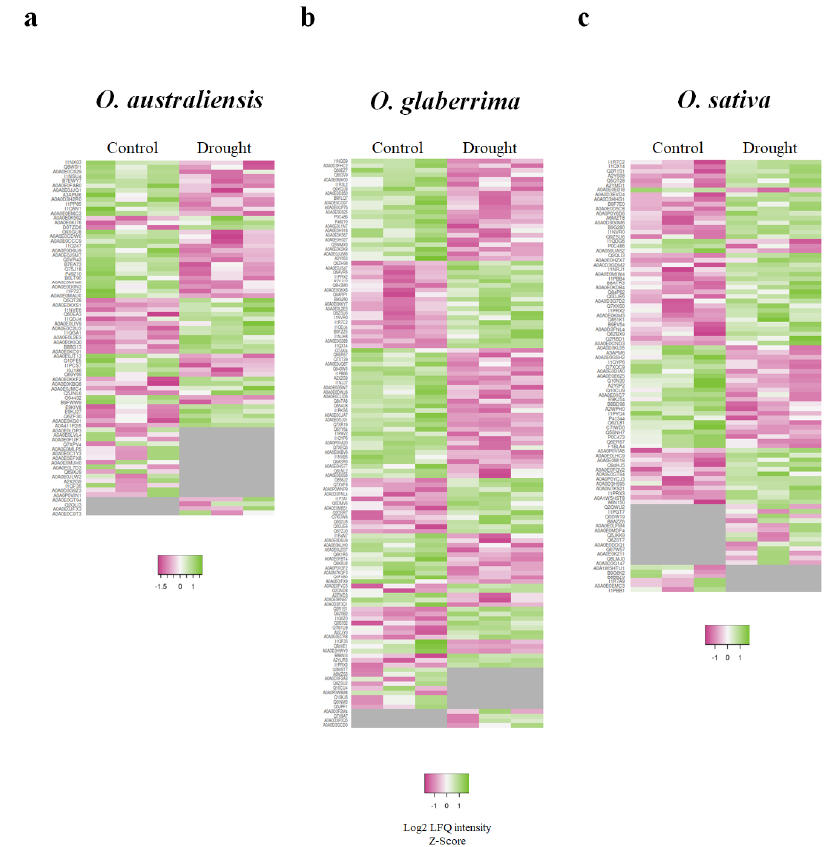
Figure 3. Heatmaps showing relative abundance intensity of proteins induced in response to drought stress across three species of rice. ( a ) O. australiensis , ( b ) O. glaberrima , and ( c ) O. sativa . The gray boxes show zero intensity. Columns indicate individual replicates.